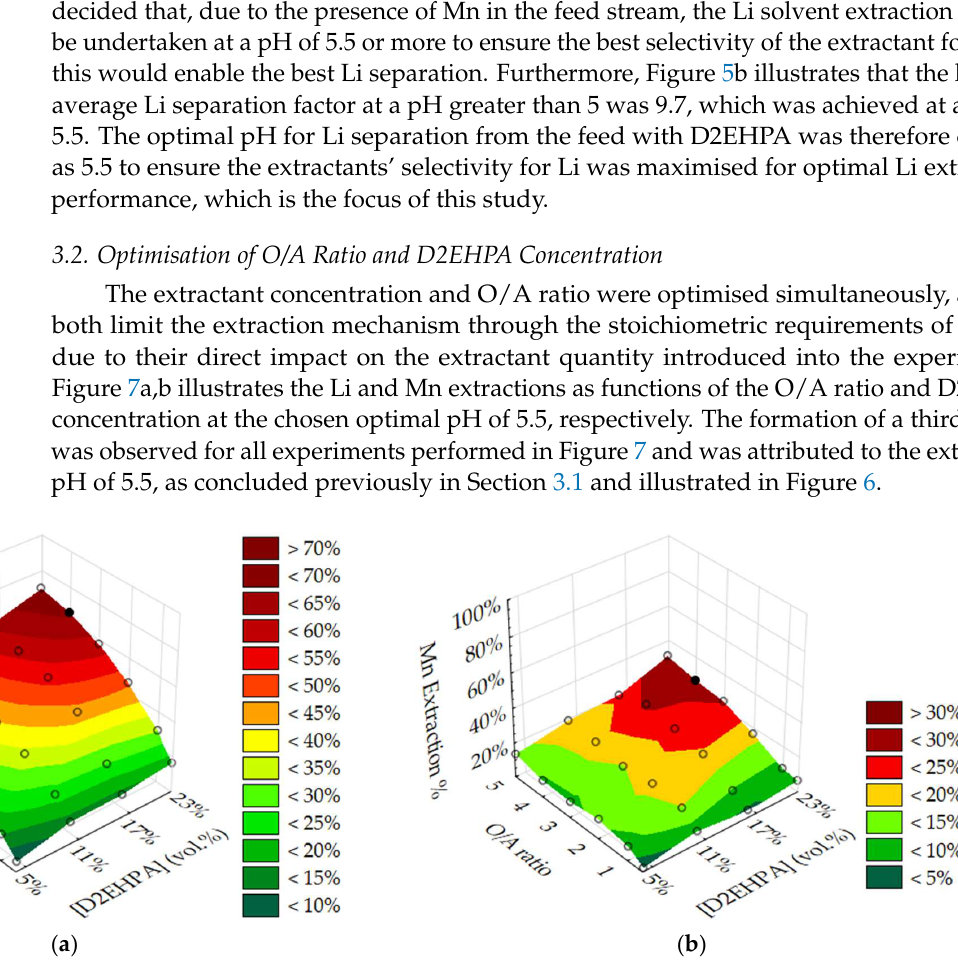
9 of 20 Figure 6. Phase volume distribution as a function of pH.